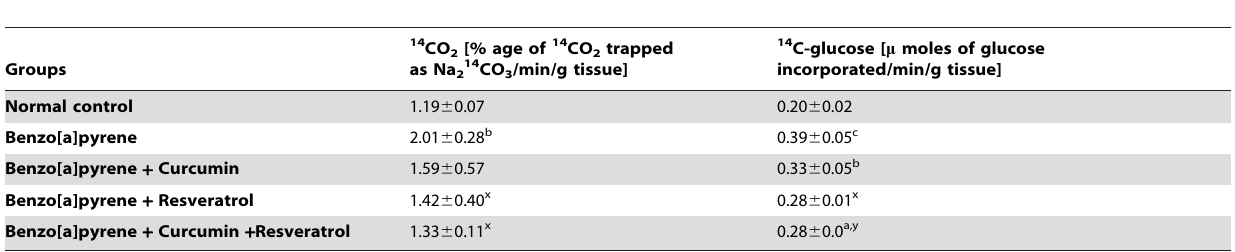
Table 3. Effects of curcumin and resveratrol treatments for 22 weeks on the uptake of 14 C-glucose in lungs during benzo[a]pyrene induced lung carcinogenesis.